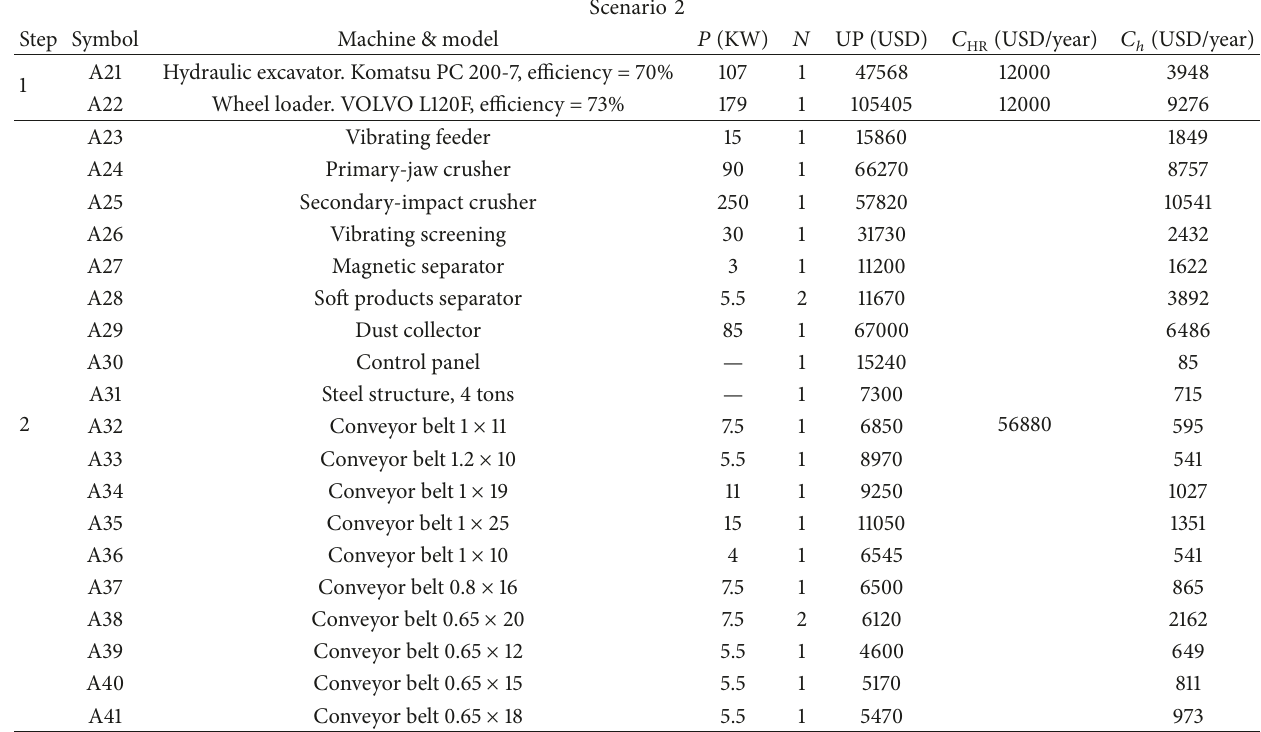
Table 4: The specifications of machinery in the recycling plant. Scenario